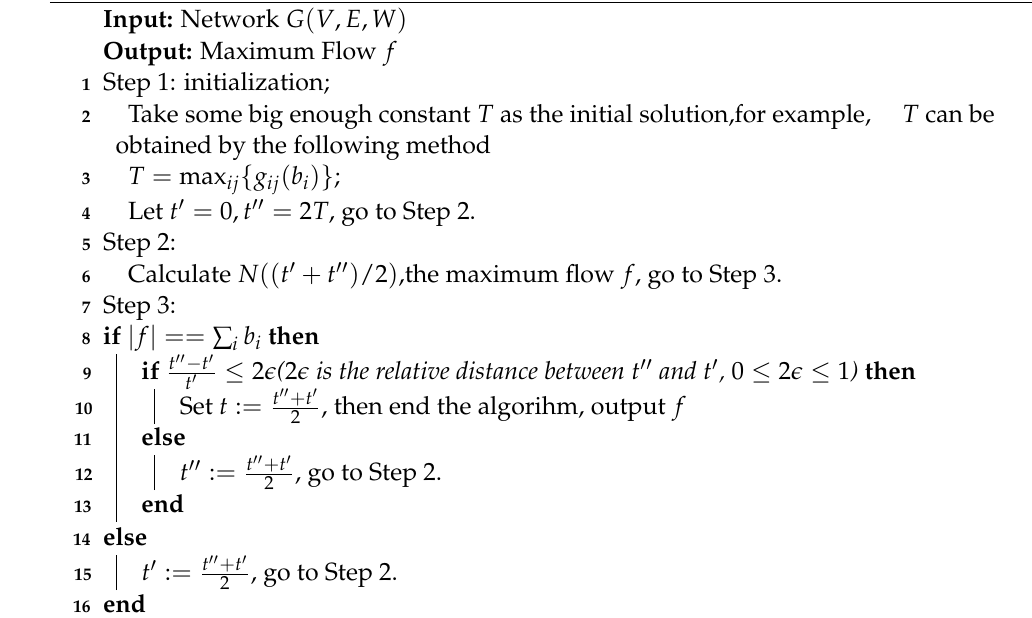
Algorithm 1: Binary search algorithm based on network